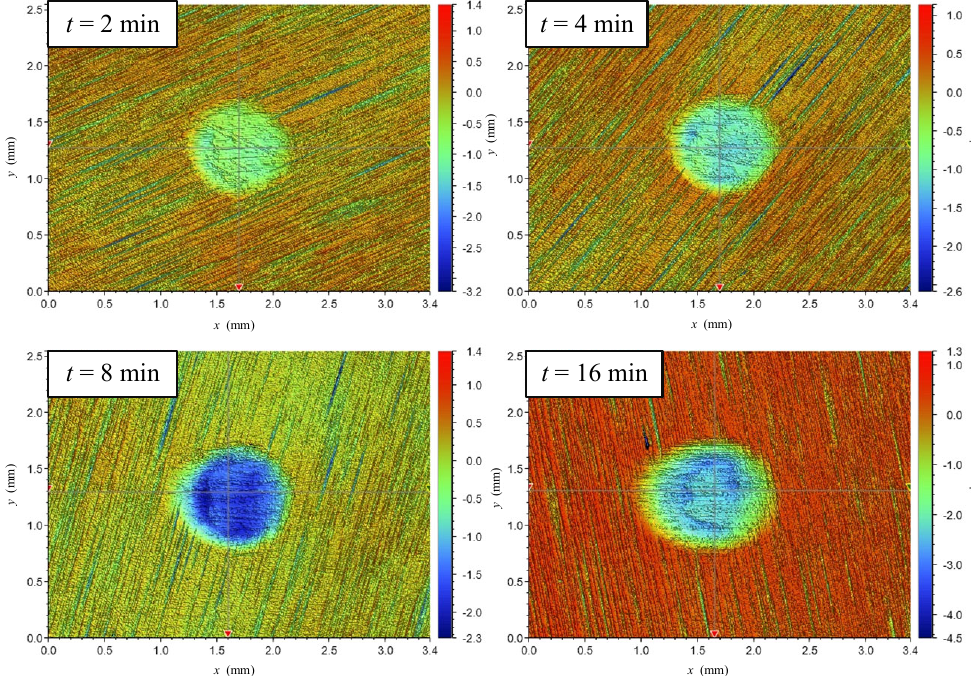
Fig. 4 Scanned disk surface at different wear